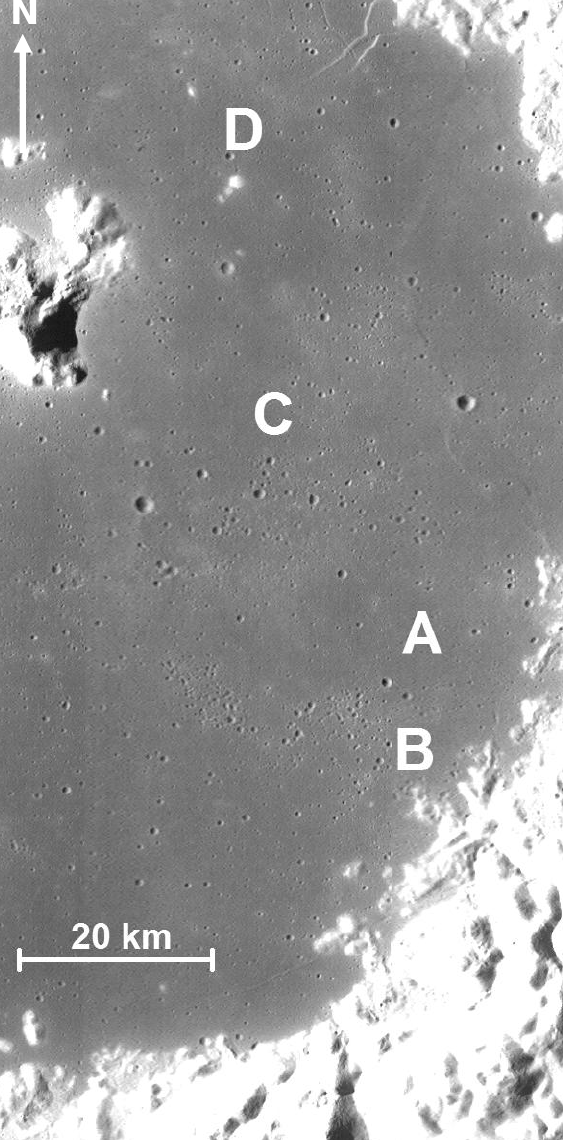
Figure 7. Detailed view of the eastern and southeastern part of Tsiolkovsky. The regions A-D marked in Figures 5 and 6 are indicated. Contrast-enhanced excerpt from the global LROC WAC mosaic (Speyerer et al.,